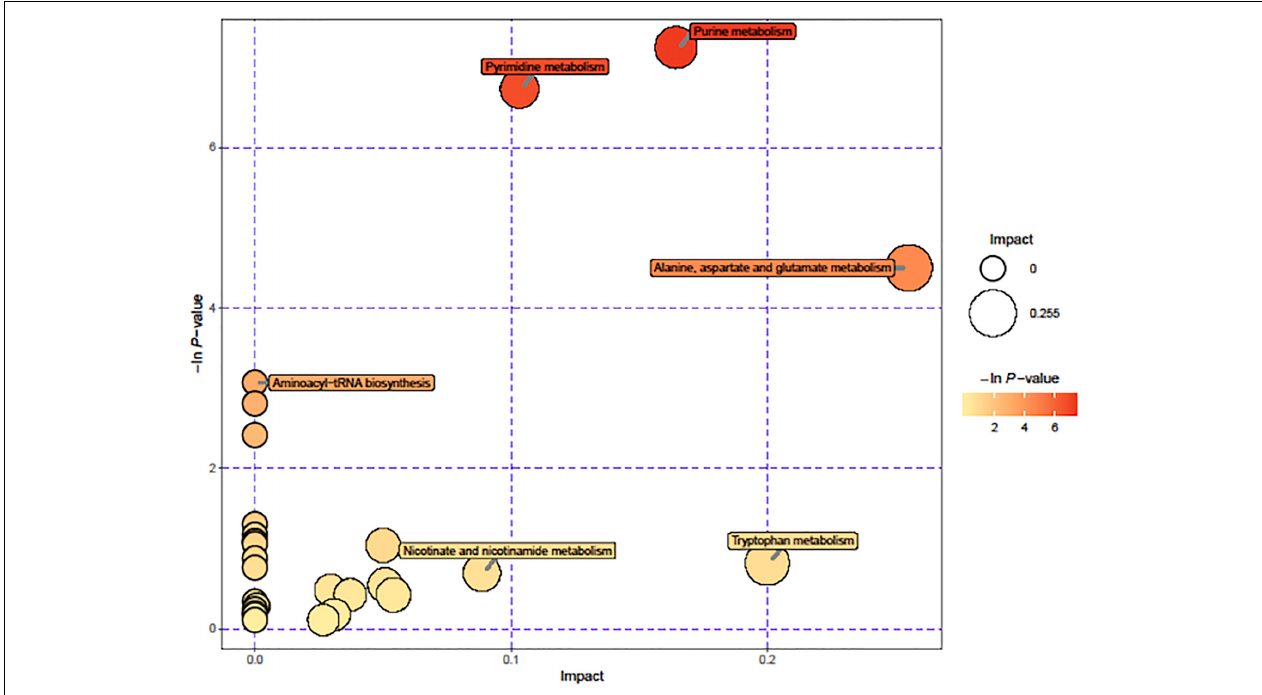
FIGURE 4 | Pathways affected by hfq knockout. The circle diameter indicates the degree of influence of the pathway, and the –ln ( p value) and color indicate the significant difference in the number of genes regulated by the pathway for the entire genomic background.